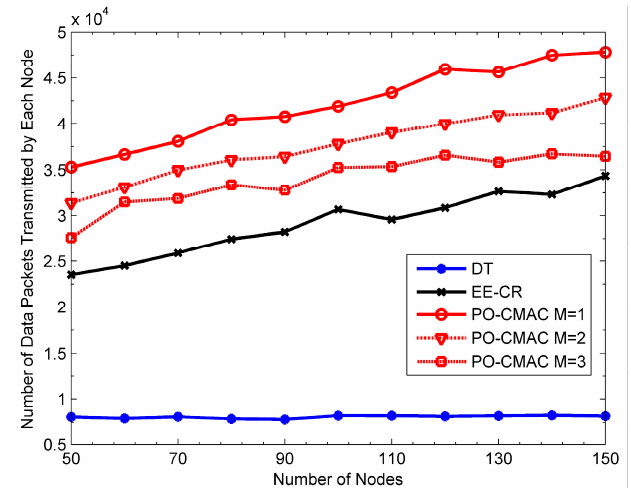
Figure 9. Network lifetime with varying N at uniform traffic load.